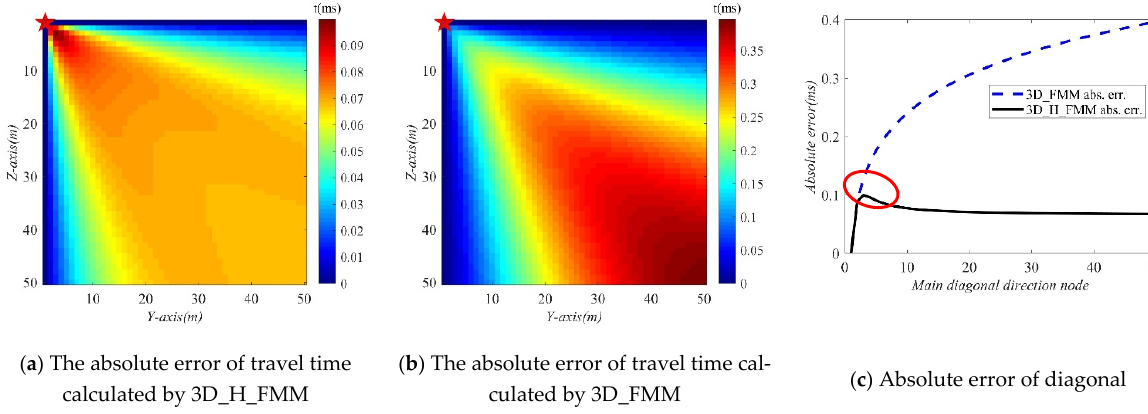
Figure 6. The absolute error, in the YZ profile, and its diagonal direction of the source point of the travel time calculated by 3D_H_FMM and 3D_FMM in the Case A: small-scaled homogeneous model.